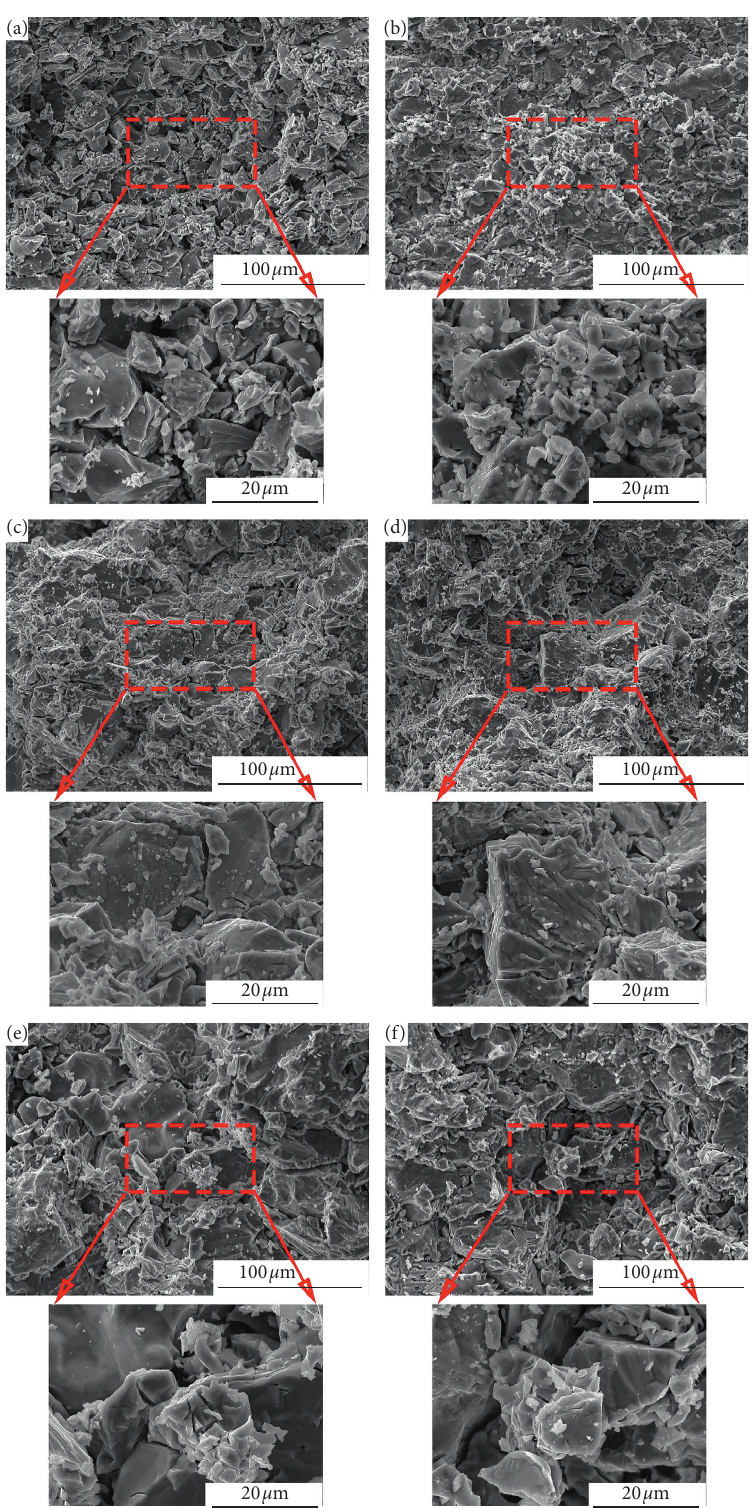
Figure 11: SEM images of TiH 2 green compacts: (a) 0–38 μ m 250MPa, (b) 0–38 μ m 650MPa, (c) 0–125 μ m 250MPa, (d) 0–125 μ m 650MPa, (e) 88–125 μ m 250 MPa, and (f) 88–125 μ m